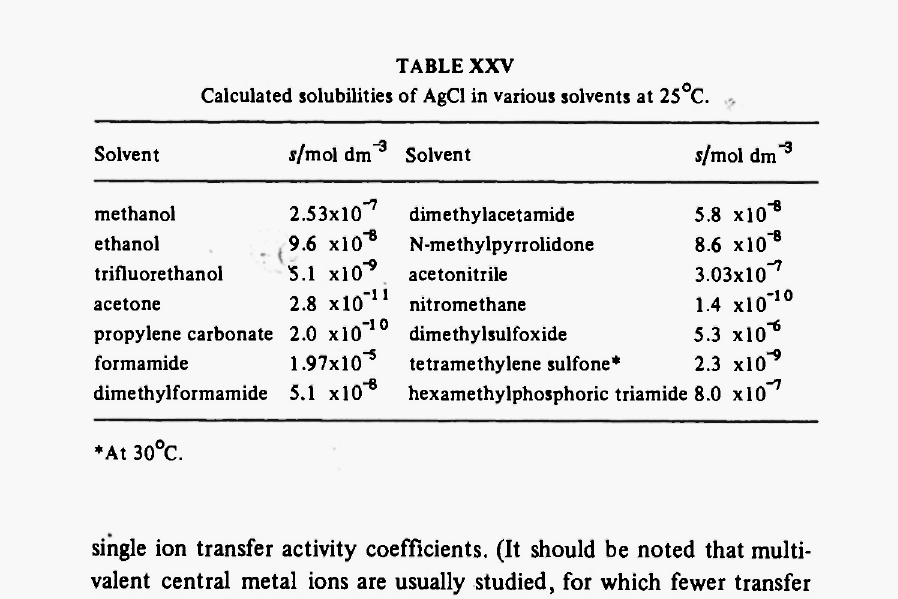
Calculated solubilities of AgCl in various solvents at